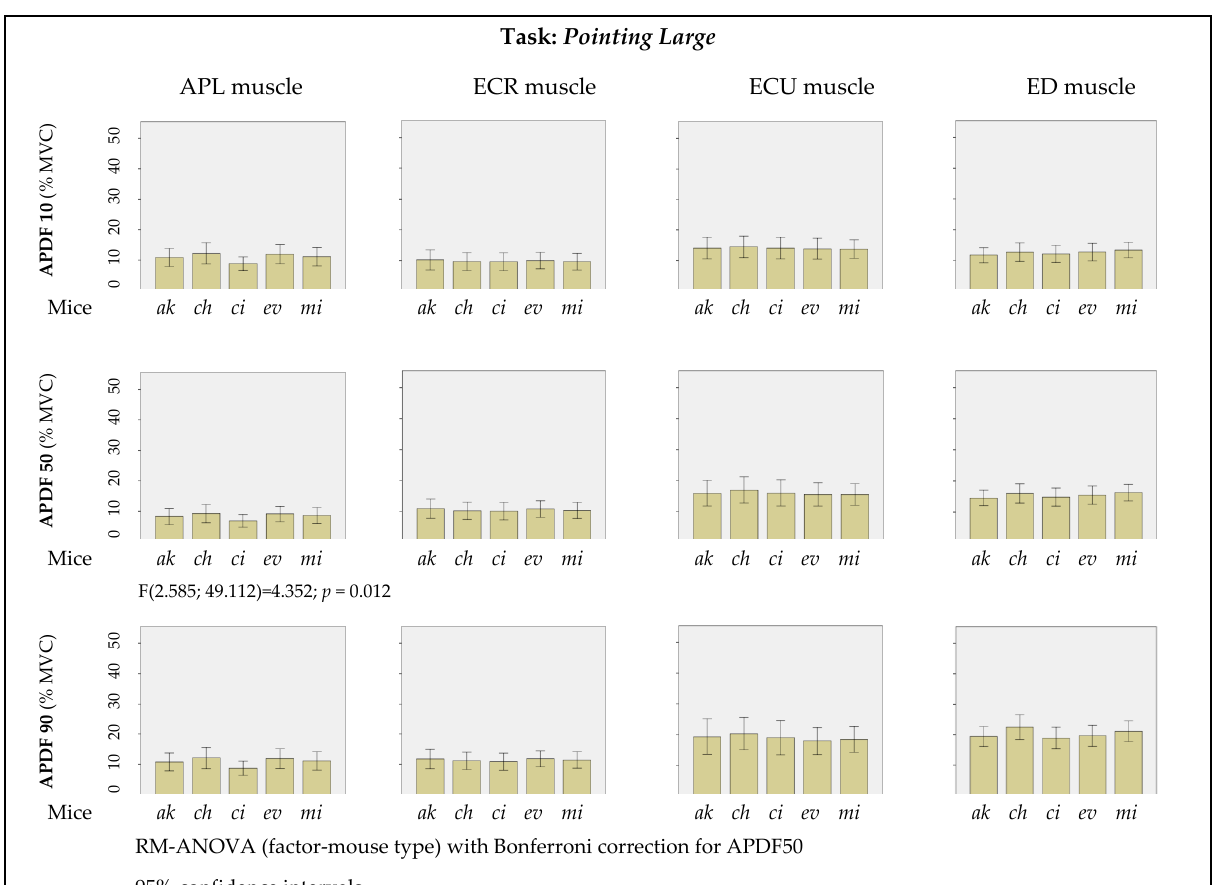
Figure 12. Muscular activity by PC mice geometry performing the pointing large task (APDF 10, 50, 90).